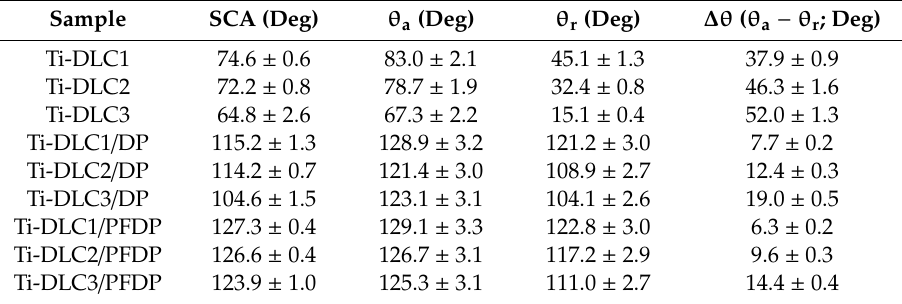
Table 1. Results of wettability measurements of Ti-DLC coatings before and after modification by DP and PFDP